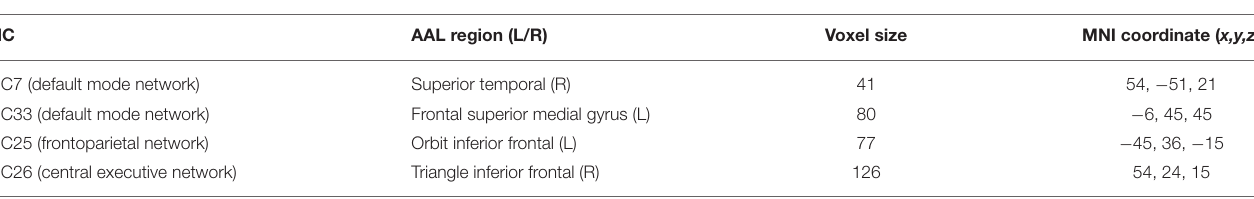
TABLE 3 | post-hoc t-testing of the four brain regions. Brain region BD-D VS. BD-M BD-D VS.